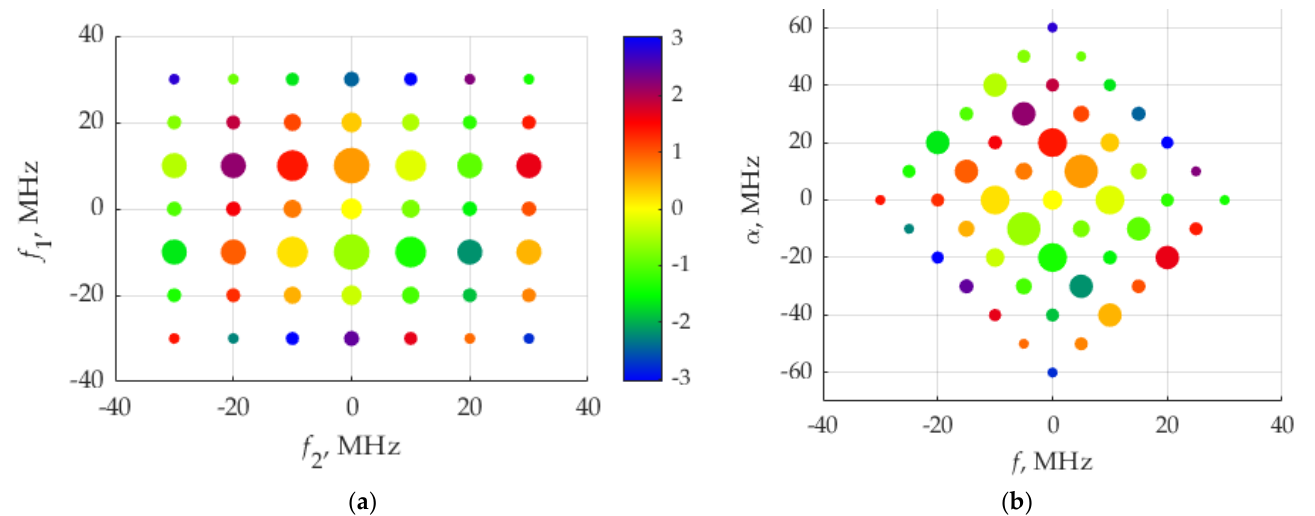
Figure 5. Diagrams of bifrequency spectrum ( a ) and CSCD ( b ) for the case of finite sum of harmonics current.